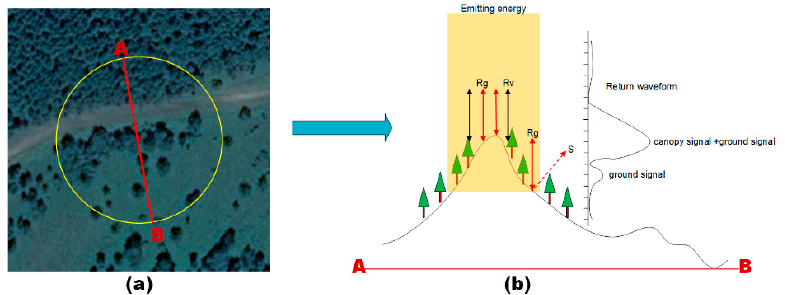
Figure 8. An example of GLAS observations with complex terrain. ( a ) High-resolution remote-sensing image for the GLAS observation area. The yellow circle is the footprint of the GLAS observation, with a diameter of 65 m. ( b ) Schematic diagram of the cross-section along the line segment “AB” shown in ( a ). It can be noted that the ground echo signal (Rg) was mixed with the canopy echo signal (Rv) because of the complex terrain. In addition, the obvious scattering phenomenon (S) on the slope area caused the echo energy of the last Gaussian component to be very small.